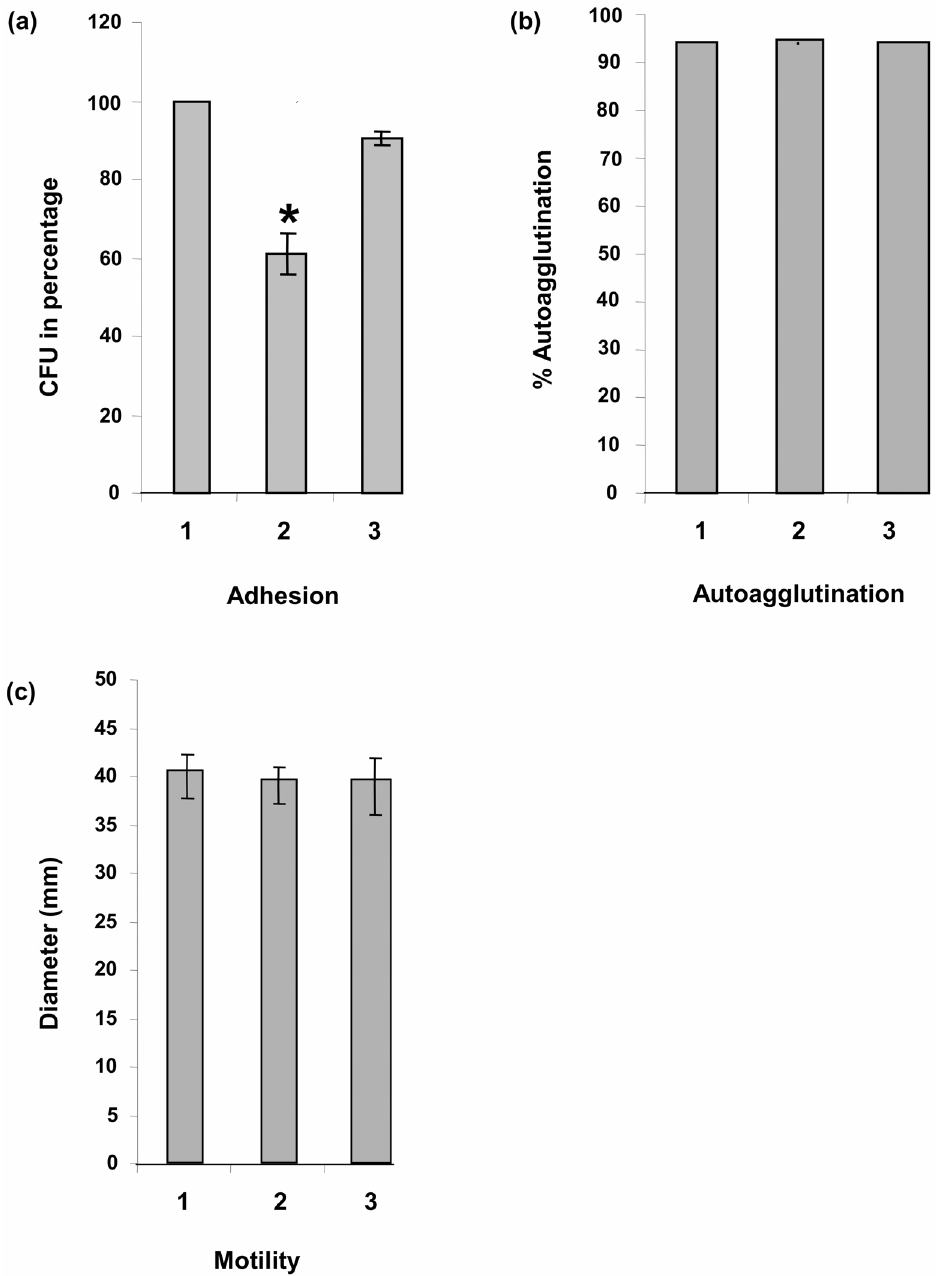
Figure 3. Assays to test for adhesion, autoagglutination and motility of the strains under investigation. (1) parental strain NCTC 11168, (2) cj0268c knockout mutant (NCTC 11168:: cj0268c ), (3) complemented knockout mutant (NCTC 11168:: cj0268c- comp- cj0268c ). (a) Loss of cj0268c reduces the capability of C. jejuni to adhere to Caco2 cells. Defining the number of wild type strain NCTC 11168 colonies obtained performing adhesion assays as 100%, the mean value of colonies from the mutant NCTC 11168:: cj0268c was 60.9% ( 6 5.18, P , 0.0039) in contrast to NCTC 11168:: cj0268c -comp- cj0268c with a recovery rate of 96.4% ( 6 1.77). (b, c) Gene cj0268c does neither impair the property of C. jejuni to autoagglutinate nor the motility of the pathogen. By performing corresponding tests, no differences among the bacterial strains under investigation could be detected. Both, the percentage of autoagglutinated bacteria and the motility zones did not show any significant differences between wild type, mutant and complemented mutant. doi:10.1371/journal.pone.0081069.g003 colonies recovered from the parental strain NCTC 11168 as To further phenotypically characterize the cj0268c -deficient 100%, the mean value of corresponding colonies for the mutant mutant, we performed assays to test for altered motility or an NCTC 11168:: cj0268c was 60.9% ( 6 5.18, P , 0.0039) whereas the affected capacity to autoagglutinate compared to the wild type strain and the complemented mutant. As shown in Figures 3b and recovery rate of colonies for the complemented strain was 96.4% ( 6 1.77) which represents the wild type adhesion level (Fig. 3a). 3c the mutant strain exhibited the same motility and autoagglu-